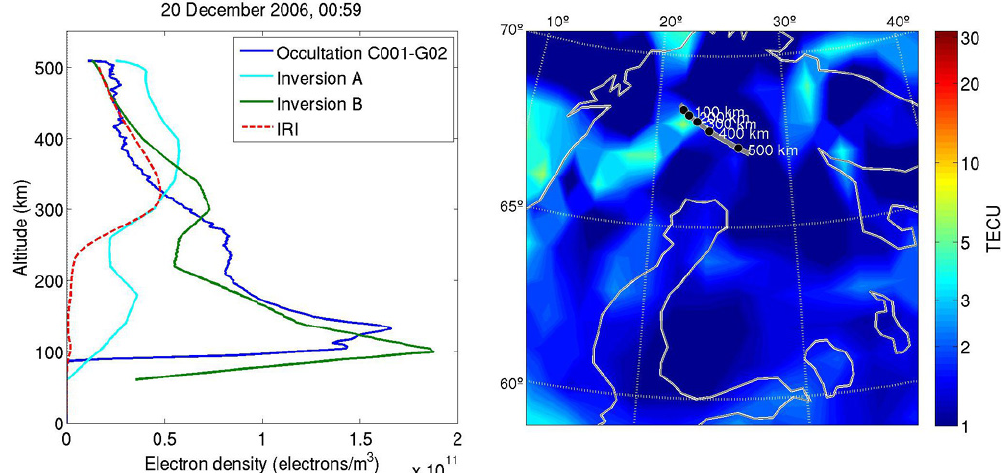
Fig. 11. Comparison between inversion result and occultation measurement, similarly as in Fig. 10, for 20 December, 00:59, between COSMIC satellite 1 and GPS satellite 2.